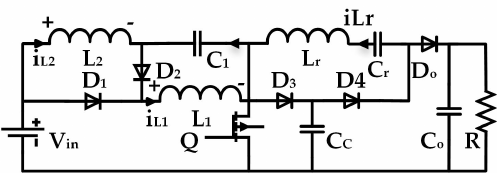
Figure 1. The equivalent circuit of the proposed